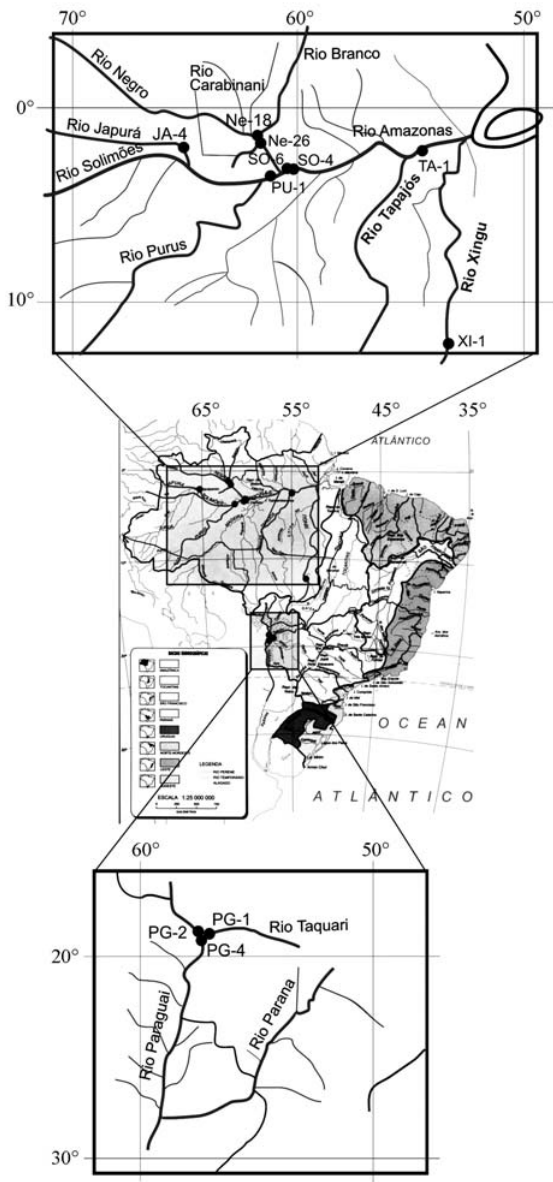
Figure 1 - Map showing the distribution of the 11 Brazilian Oryza glumaepatula